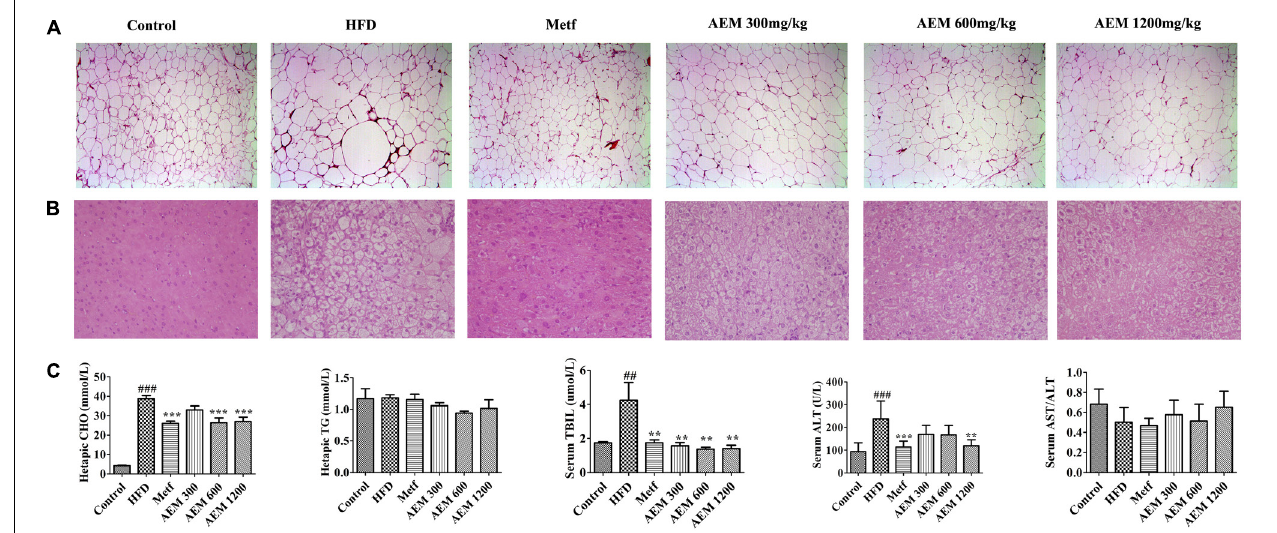
FIGURE 1 | Effects of aqueous extract of black maca (AEM) on the histology of epididymal white adipose tissue and liver and the hepatic lipid profiles in golden hamsters. (A) The epididymal white adipose tissue sections were stained with H&E. (B) The liver sections were stained with H&E. (C) The hepatic cholesterol (CHO), hepatic triglyceride (TG), serum total bilirubin (TIBL), serum aminotransferase (AST), and AST/alanine aminotransferase (ALT) levels were measured. Data are presented as the means ± SEMs. # P < 0.05, ## P < 0.01, ### P < 0.001 compared with the control group; ∗ P < 0.05, ∗∗ P < 0.01, ∗∗∗ P < 0.0 compared with the HFD model group, n =